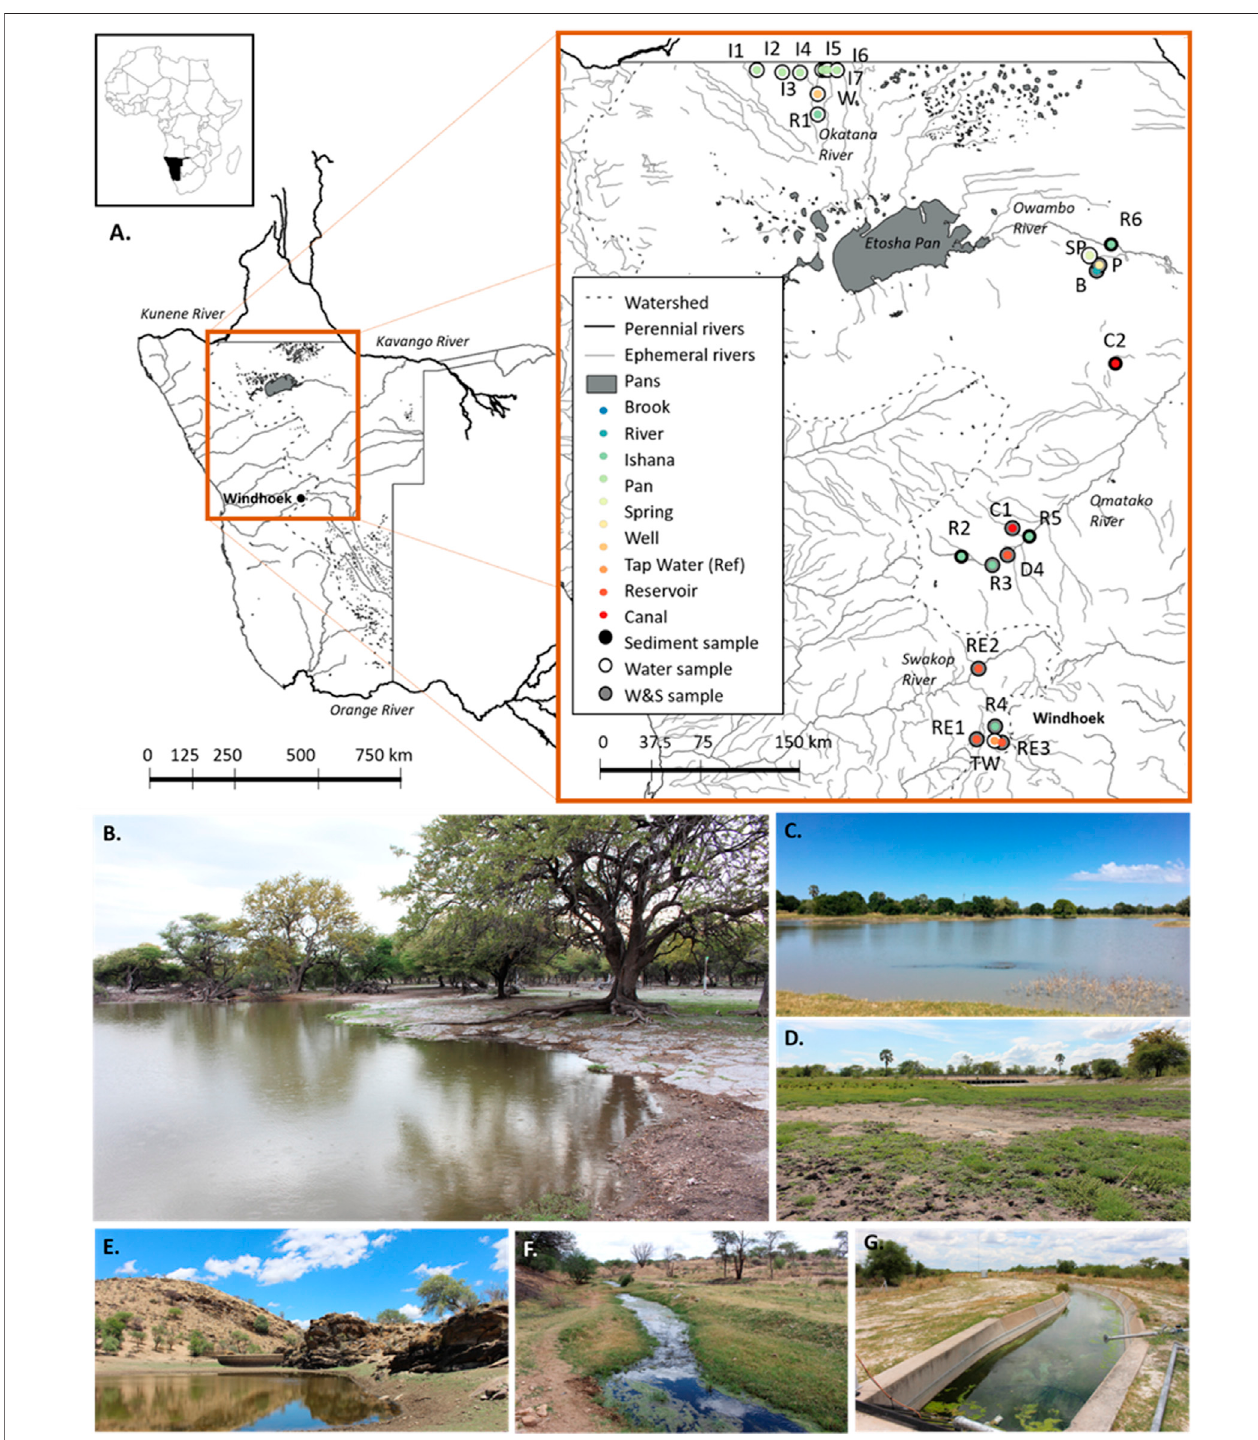
FIGURE 1 | (A) Study area and sampling sites. A range of arti fi cial (canal-C, reservoir-RE, hand-dug wells-W, tap water in Windhoek used as a reference-TW) and natural (river-R, brook-B, spring-SP, ishana-I, and pan-P) environment types were sampled. Sampling sites are denoted by points and corresponding names (e.g. C1, R2, I3). The inner colours of points indicate the environment types sampled. For each site, the outer colours of points indicate whether samples were collected of: sediments only (black), water only (white) or both sediments and water (grey). Generated using QGIS (QGIS Development Team, 2019). Examples of surveyed environment types include a pan (B) , ishana (C) , river (dry) (D) , a reservoir (E) , a river (F) , and a canal (G) . Photographs: Rhidian Thomas and Roser Casas-Mulet.